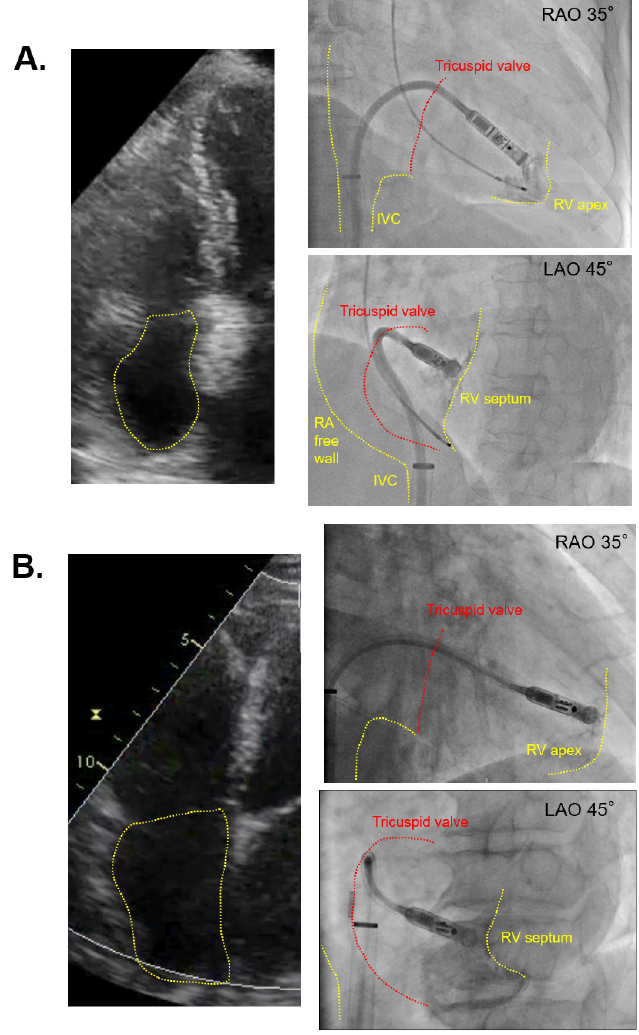
Figure 3. Echocardiography in the shortest and longest procedures. ( A ) The case of smaller right atrium with 30 min of procedure time; ( B ) the case of larger right atrium with 185 min of procedure time; echocardiographic views indicate four chambers, viewing from the apex, and yellow dashed lines indicate the right atrium; IVC = inferior vena cava, RV = right ventricle.